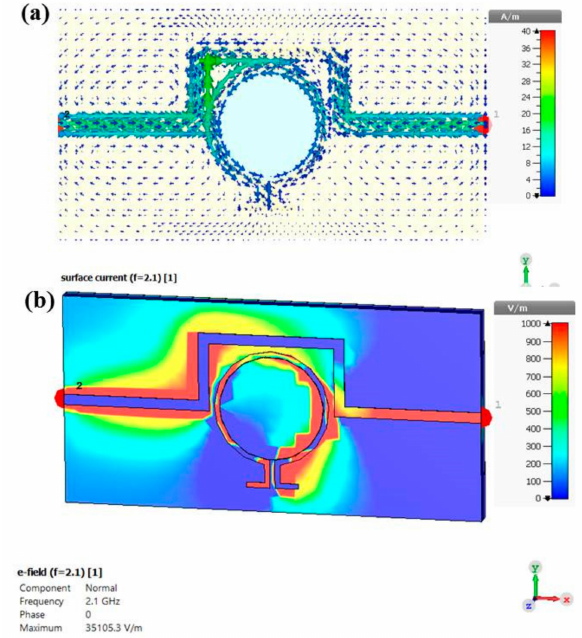
Figure 6. Simulated results for the proposed sensor structure at 2.1 GHz: ( a ) surface current distribution; ( b ) electric field